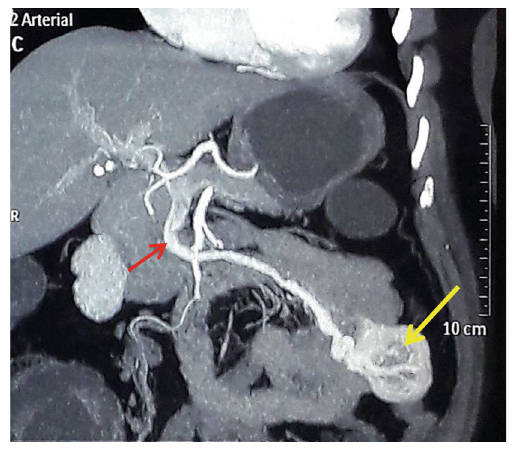
Figure 4: Resected specimen: red arrow shows the jejunal lesion; yellow arrow shows part of the